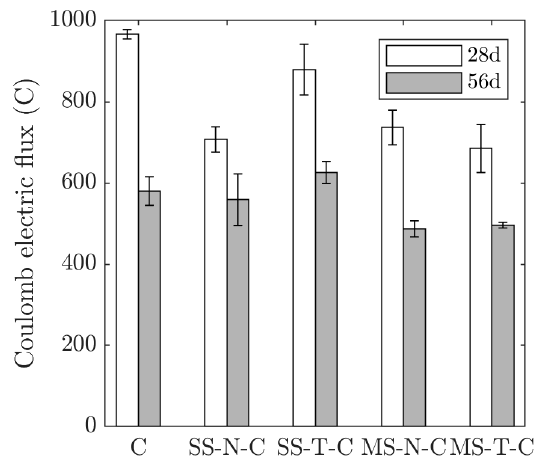
Figure 8. Six hour coulomb electric flux.